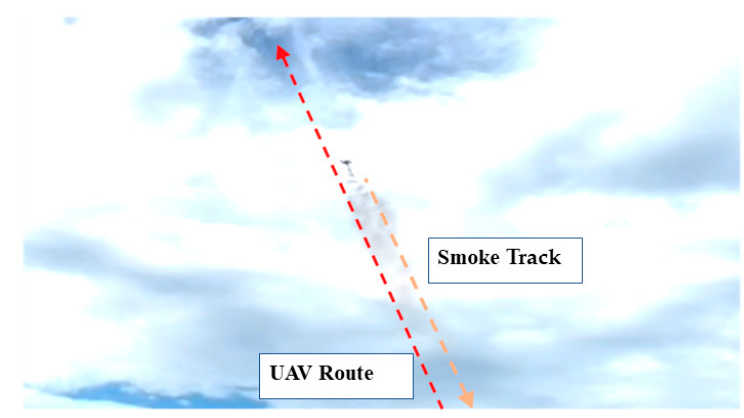
Figure 12. Smoke track correction with the AI model.